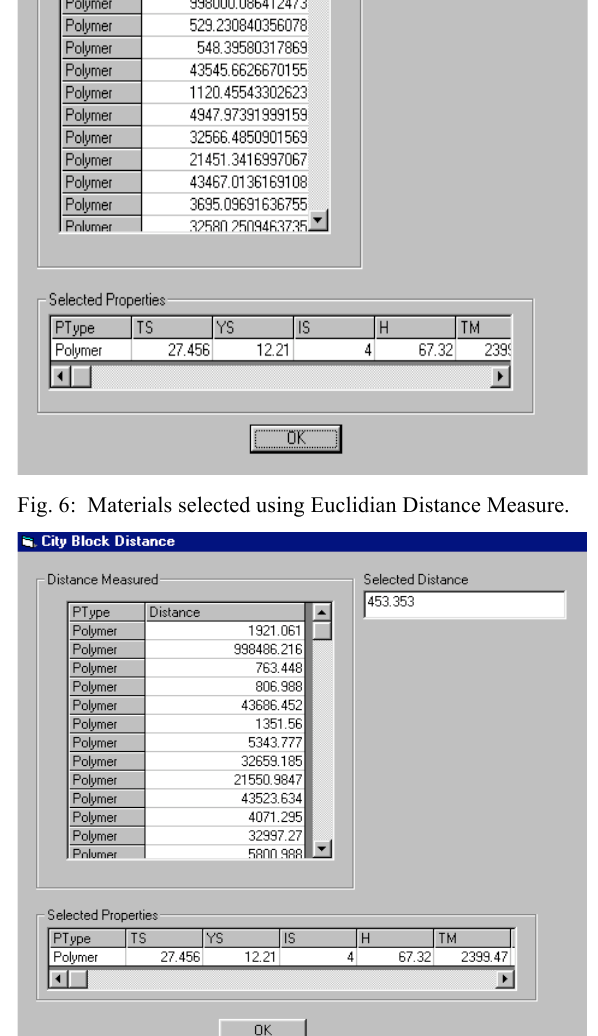
Fig. 5: Fragmented materials and the materials selected from the respective selected materials data set.